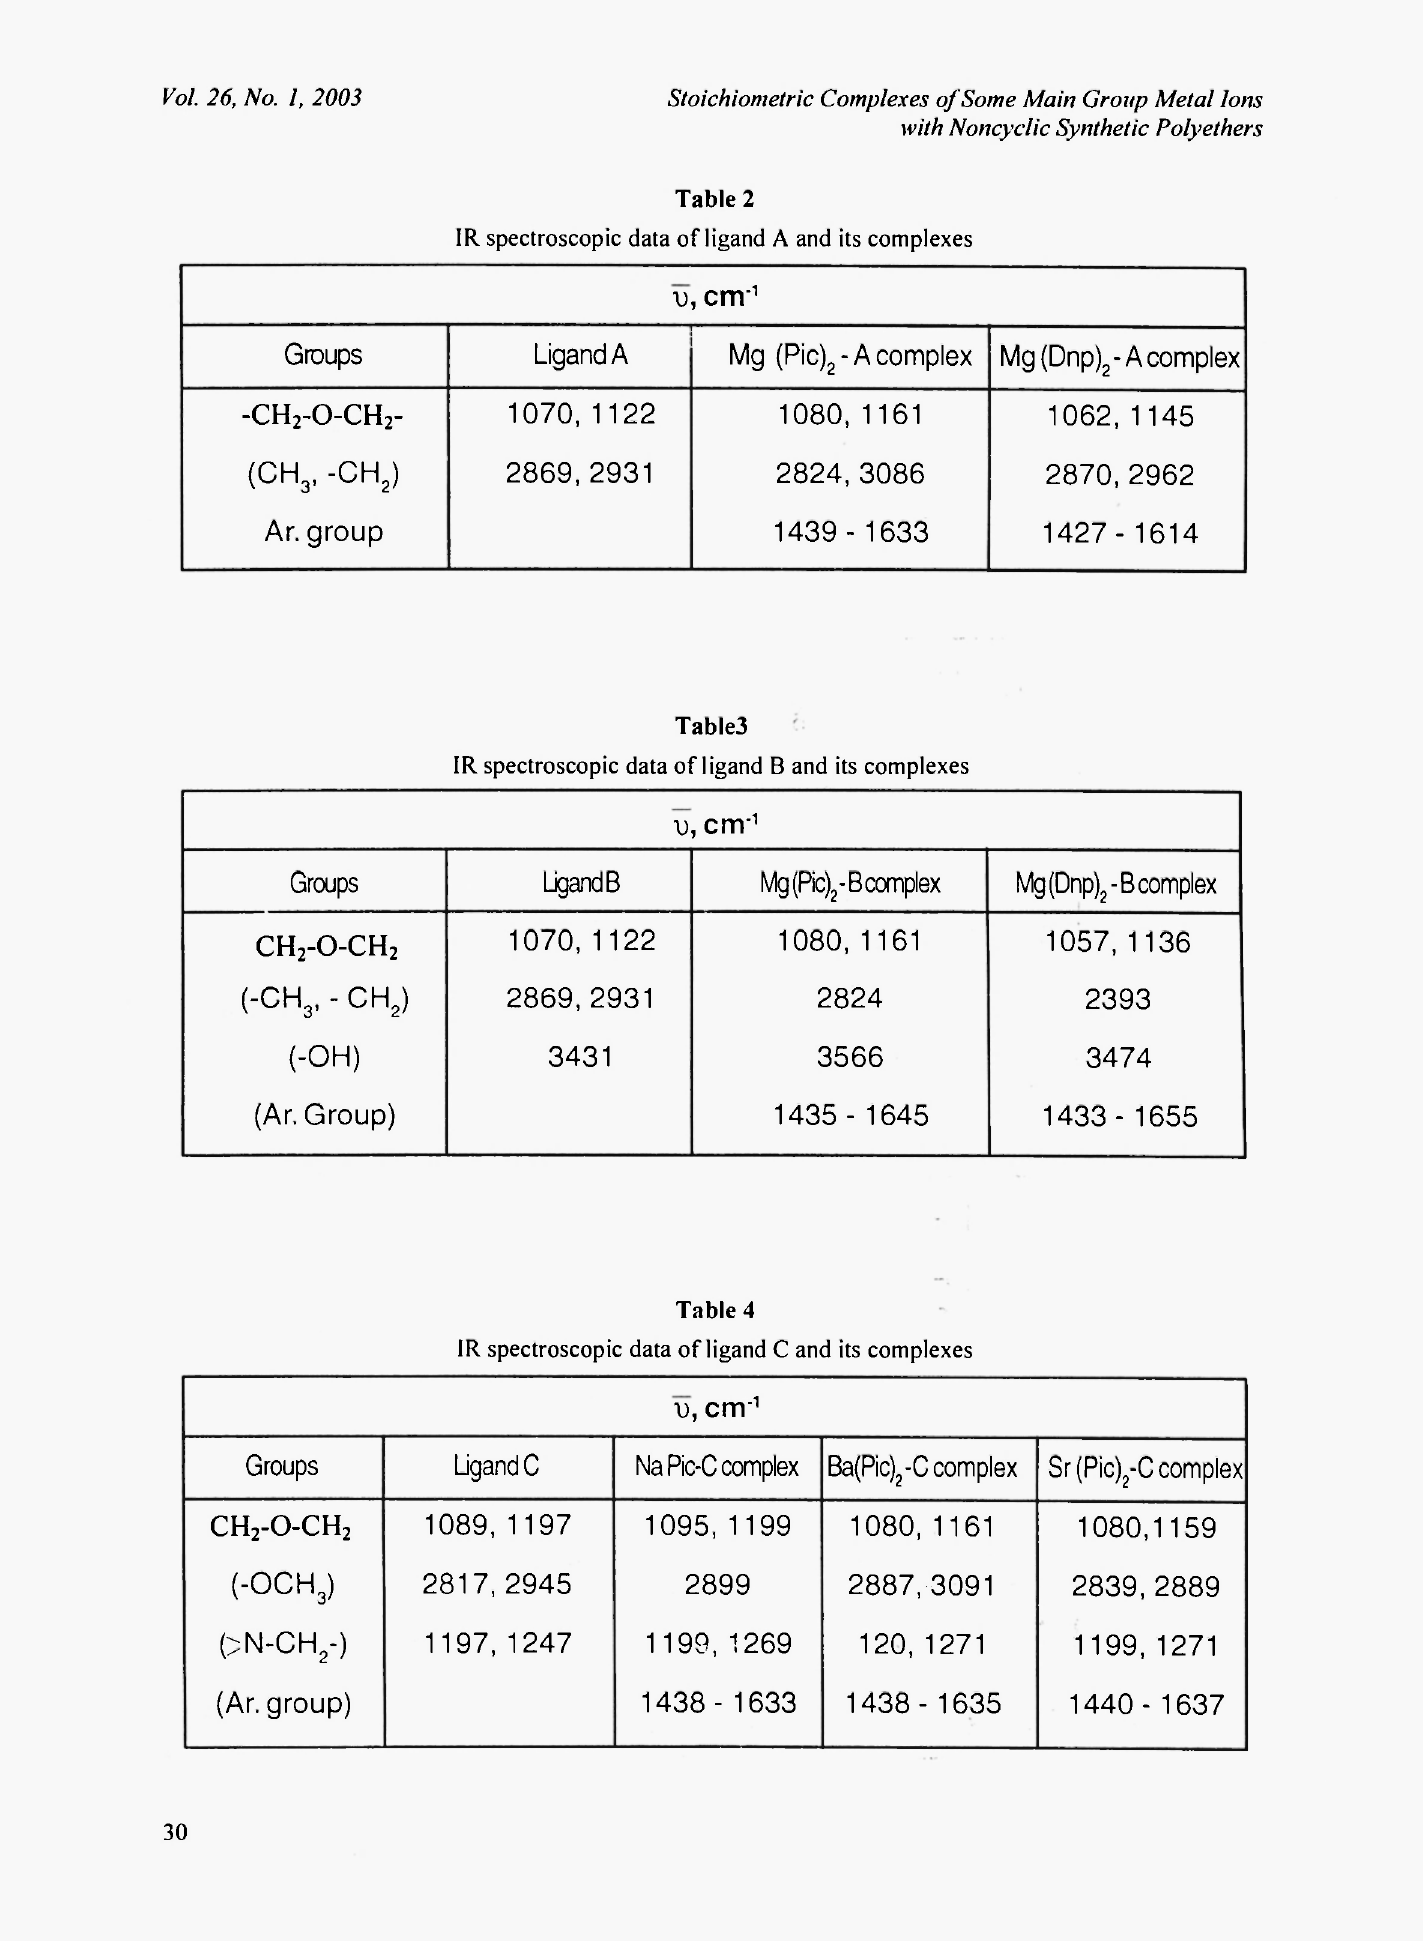
1R spectroscopic data of ligand C and its